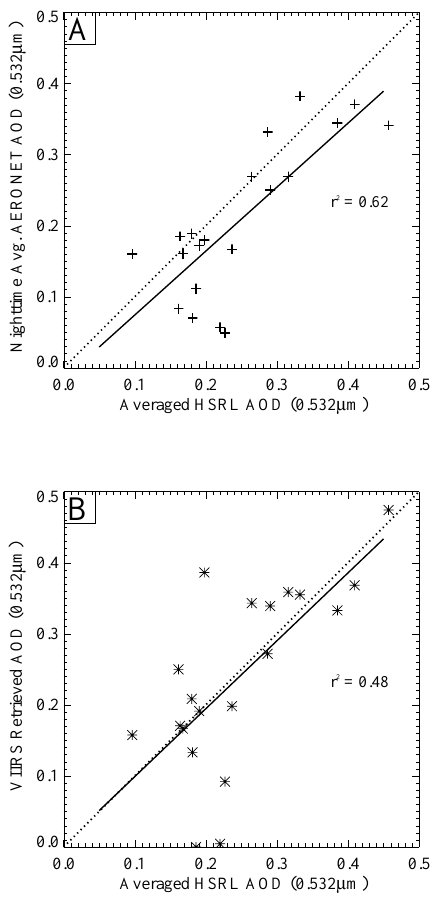
Figure 7. Straddling daytime-averaged AERONET τ (top, Fig. 7a) and VIIRS-retrieved τ (bottom, Fig. 7b) as a function of Wisconsin HSRL-retrieved total-column τ for Huntsville, Alabama. One-to- one (dotted) and best-fit (solid) lines are also shown.